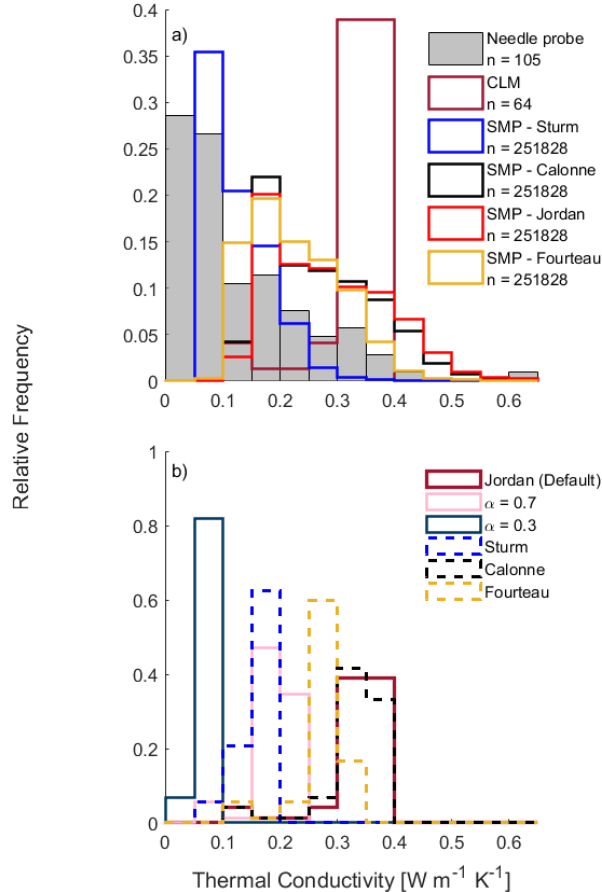
Figure 6. (a) Histograms of measured and simulated thermal con- ductivity from March 2018 and 2019 sampling campaigns; dashed lines show the four different thermal conductivity parameterisations applied to the SMP densities. (b) Sensitivity testing of simulated thermal conductivities for the same time period using both the de- fault CLM snow thermal conductivity parameterisation, application of the α correction (solid lines) and alternative snow thermal con- ductivity parameterisations (Calonne et al., 2011; Fourteau et al., 2021b; Sturm et al., 1997; dashed lines). Note the different scales on the y